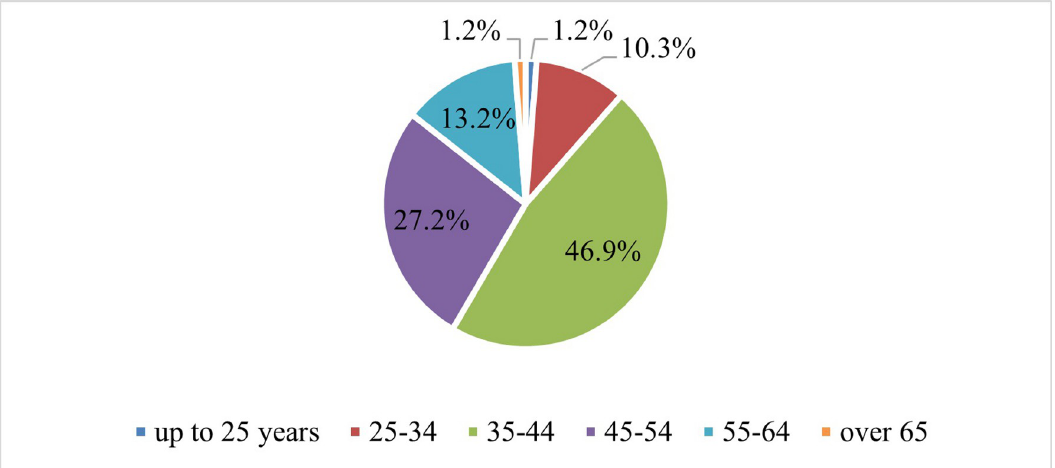
Fig 1. Sample structure according to the age of the respondents. Source: authors own calculations.